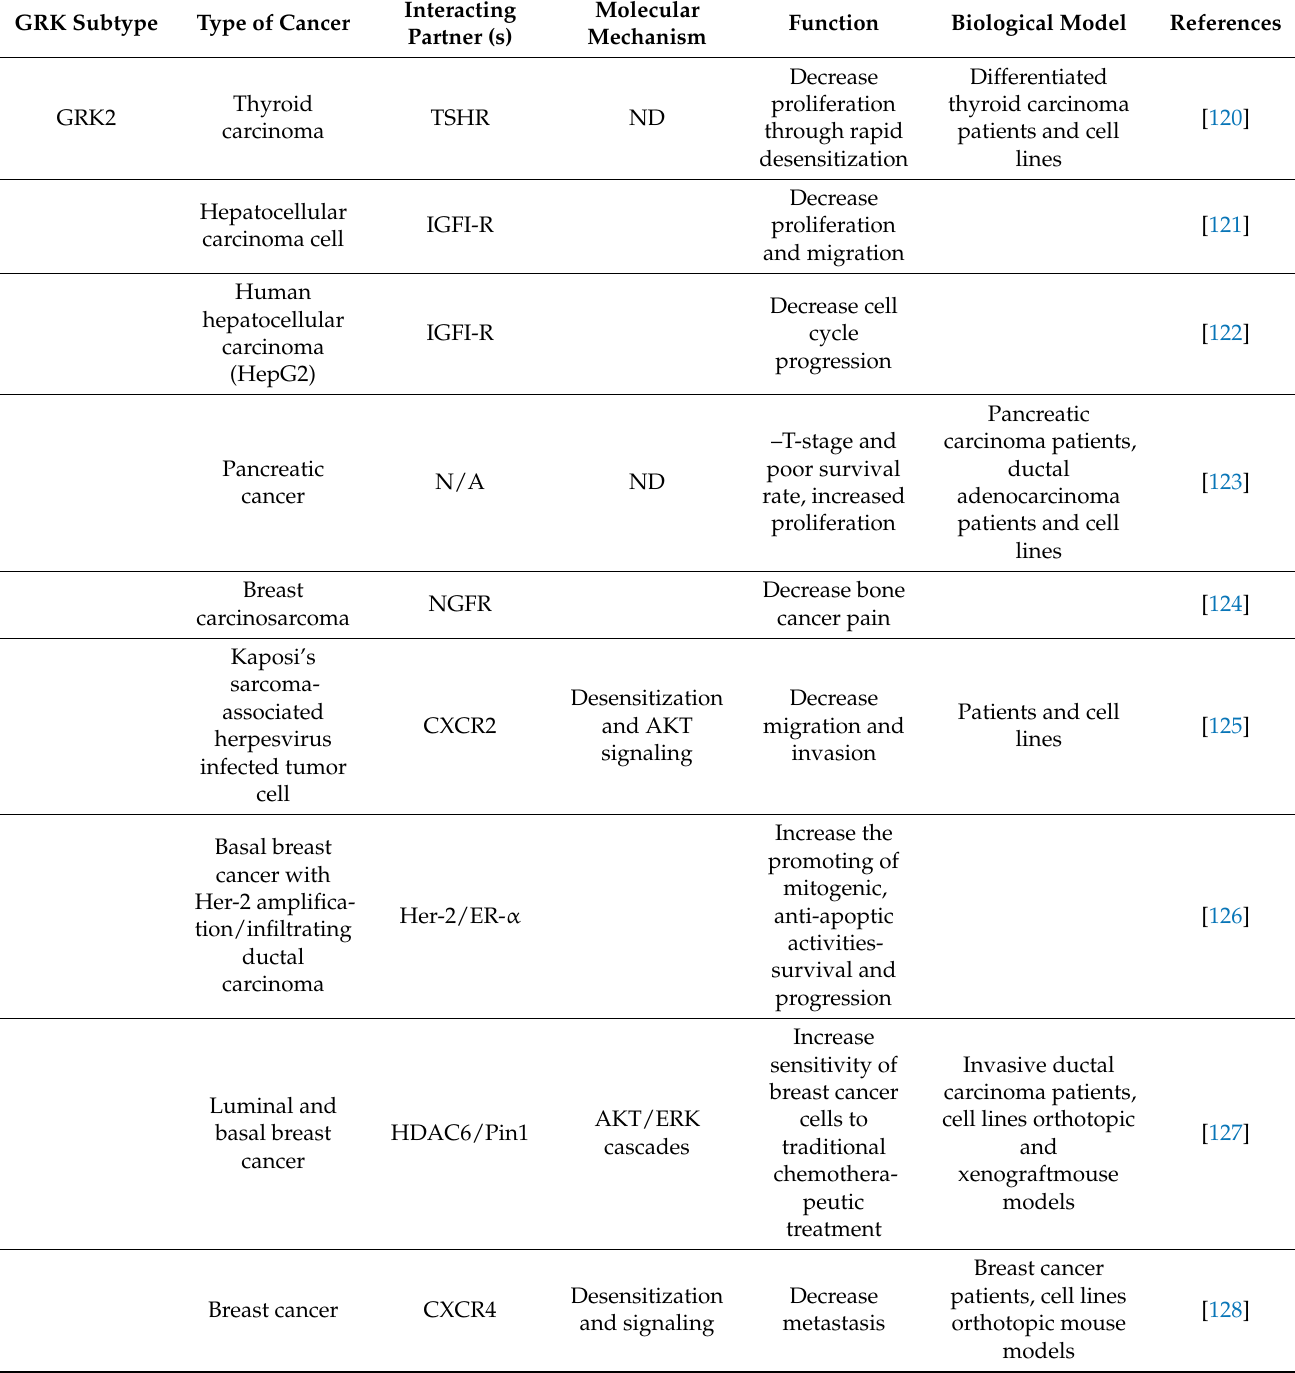
Table 2. An overview of established roles of GRK isoforms in various types of